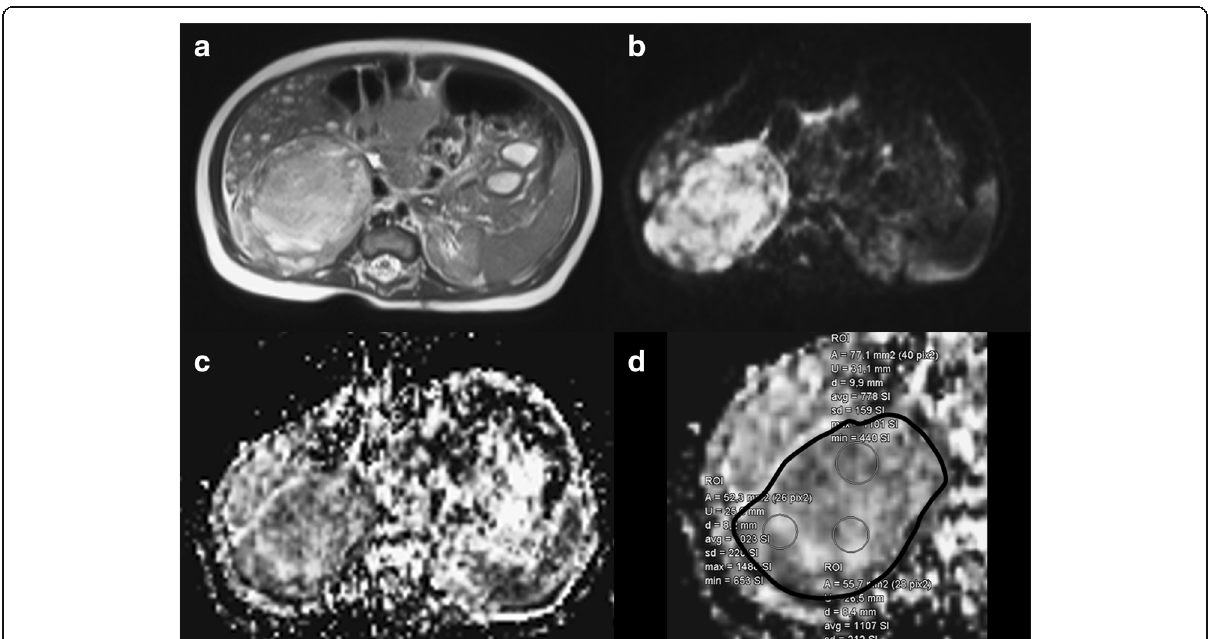
Fig. 3 Baseline MRI of a 16-month-old boy with neuroblastoma of the left adrenal gland and suspected liver metastases (liver lesions not shown). The tumour signal is notably more heterogeneous than that of the lesion shown in Fig. 2 and comprises some high-signal areas on the T2- weighted image ( a ). In b , a high signal on DWI ( b = 800 s/mm 2 ) can be appreciated while a low signal is visible on the ADC map ( c ) is, however, predominant within the tumour. The presented cross-sectional image was chosen for analysis, as the cross section at the largest tumour diameter included a higher proportion of heterogeneous tumour signal. The black solid line overlay on the magnified ADC map highlights the large ROI drawn for study purposes ( d ). Mean baseline ADC was measured as 0.706 × 10 − 3 mm 2 /s in this eventually relapsing tumour. Three small ROIs yield ADC values of 0.589, 0.638, and 2.841 × 10 − 3 mm 2 /s, the latter equalling liquefied tumour